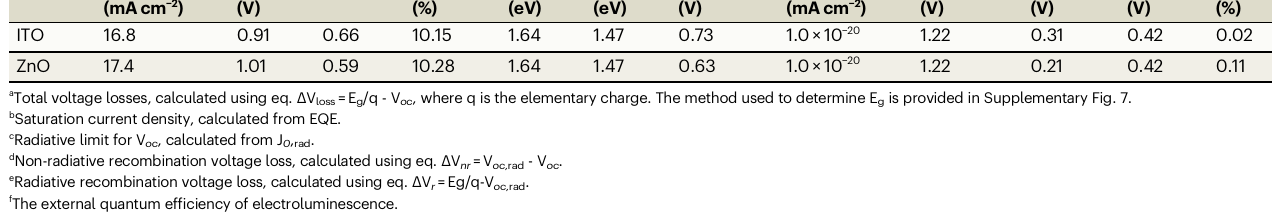
Table 1 | The representative photovoltaic performance parameters and the voltage loss values from the EQE and EL mea- surements for the PBDB-T:ITIC solar cells based on ZnO and ITO electrode. The statistical results for the photovoltaic per- formance parameters are provided in Supplementary Table 1 J sc (mAcm − 2 )